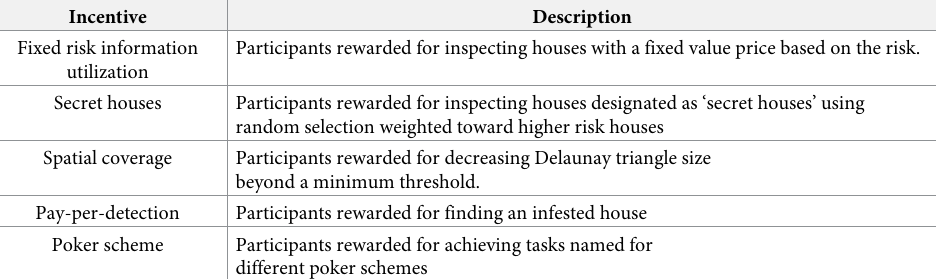
Table 1. Overview of the incentive schemes tested in this study. Detailed information for each scheme is found in the methods section and in Figs